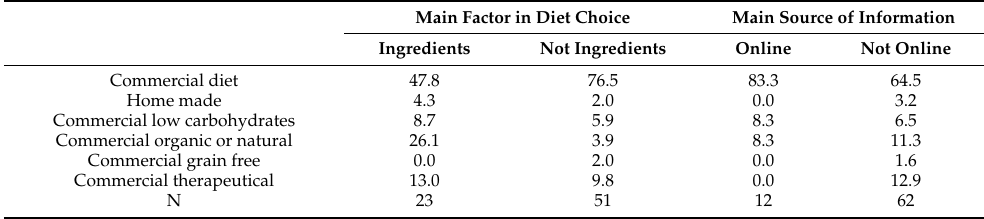
Table A3. Distribution of pet food diets for groups where the main factor in diet choice is the ingredient list or not, and the main source of information in the choice of pet foods is online content or